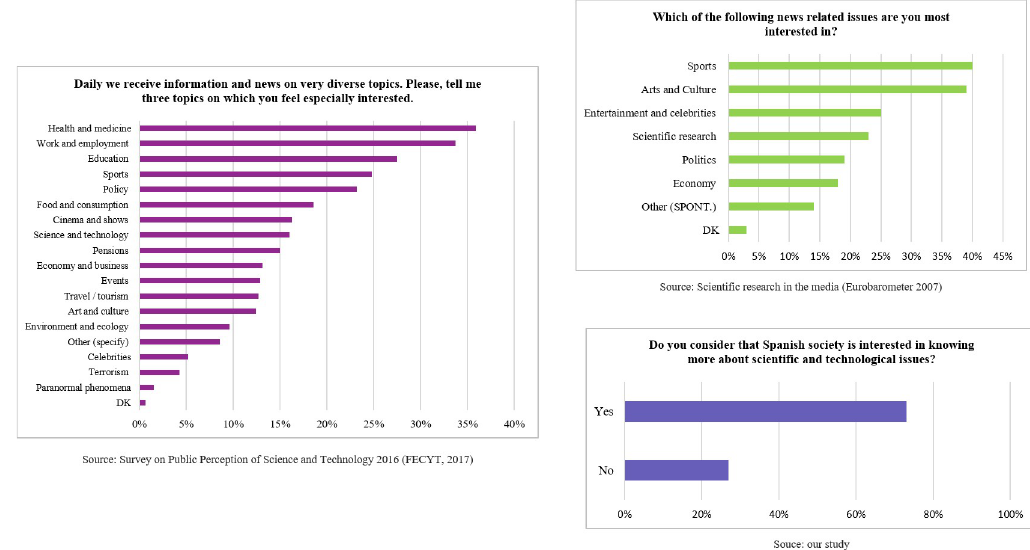
Fig 4. The perceived level of interest in science and technology by society in general (FECYT and Eurobarometer data) and scientists (our data).